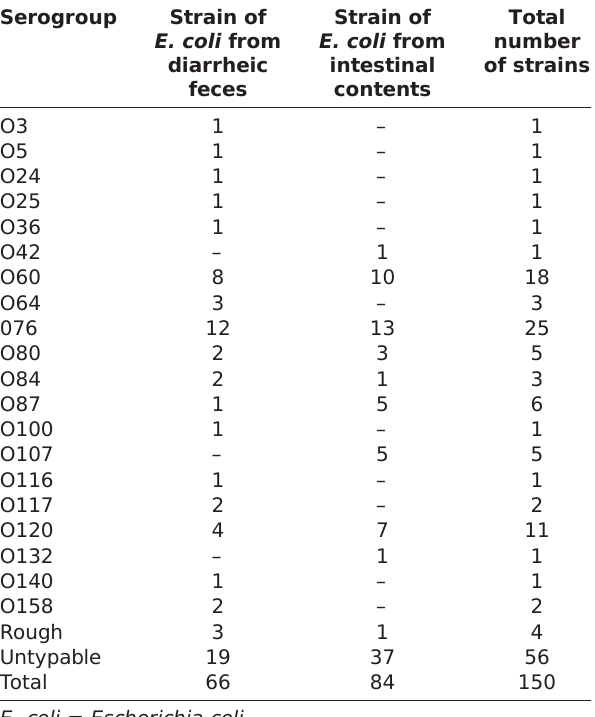
Table-1: Different serogroups of E. coli isolated from diarrheic piglets. Serogroup Strain of E. coli from diarrheic